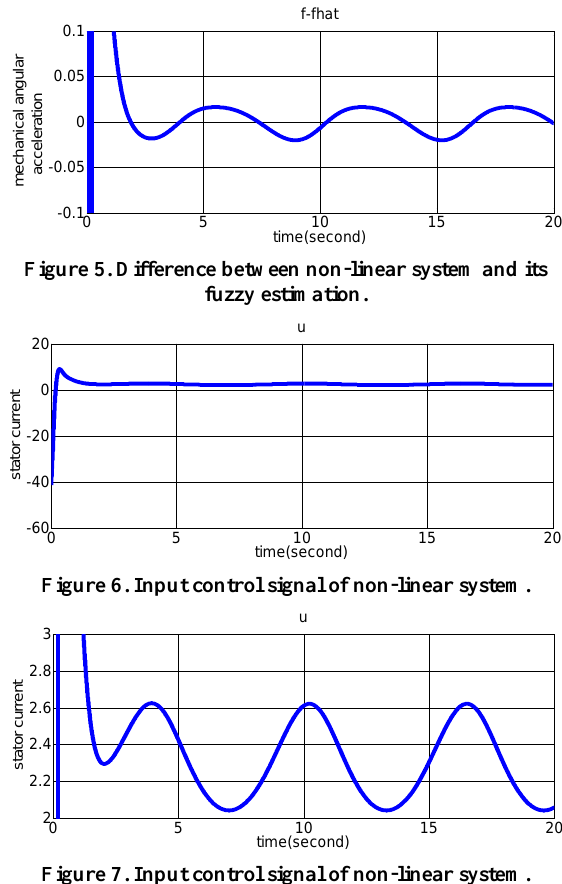
Figure 2. Reference input.